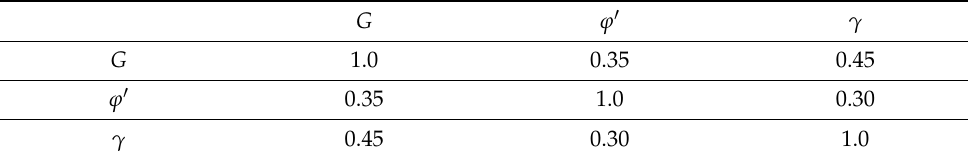
Table 4. Correlation matrix implemented for the soil characteristics taken from